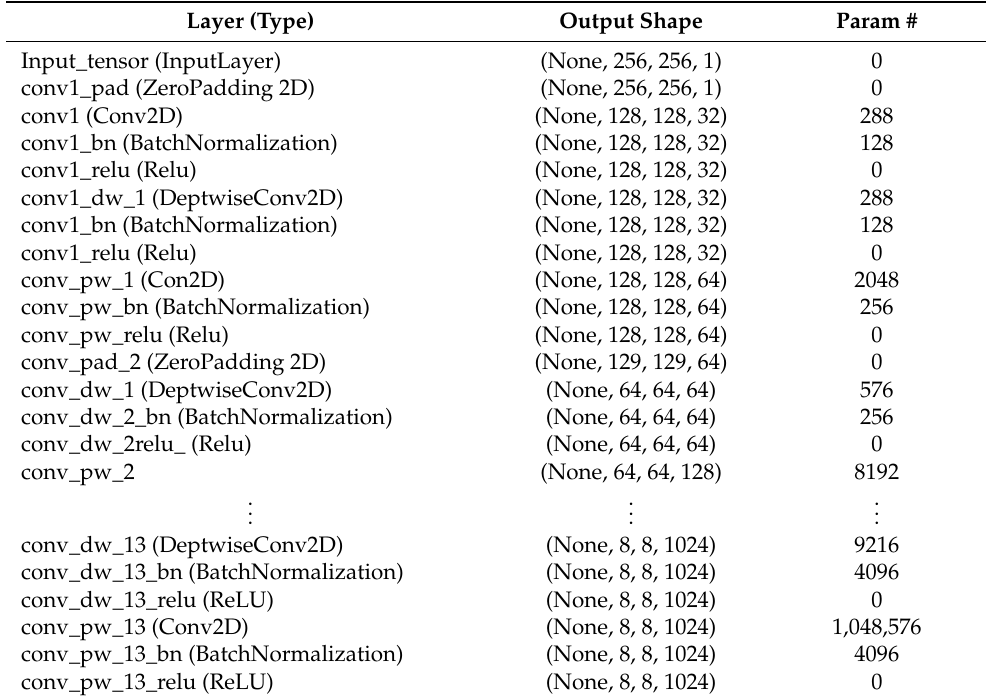
Table 3. Configuration of the proposed CNN architecture. The total number of model parameters is